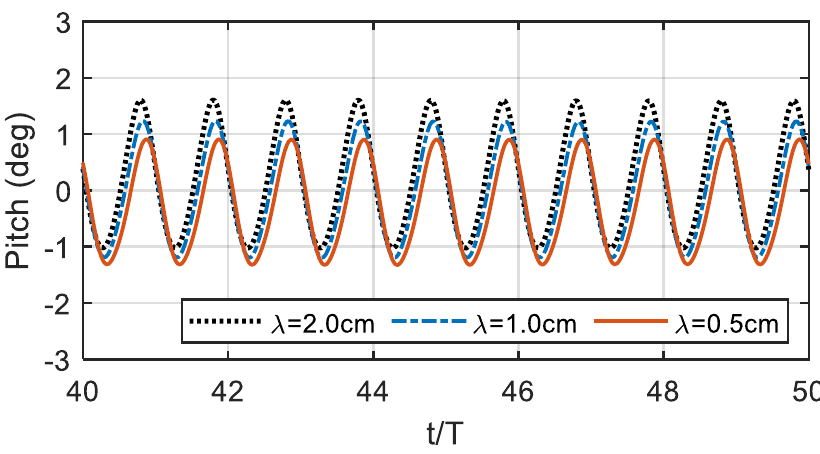
Figure 9. Variations in the pitch motion for the platform with various fishnet mesh sizes ( H = 4 cm, T = 0.91 s, and σ 2 h / g = 3.9).